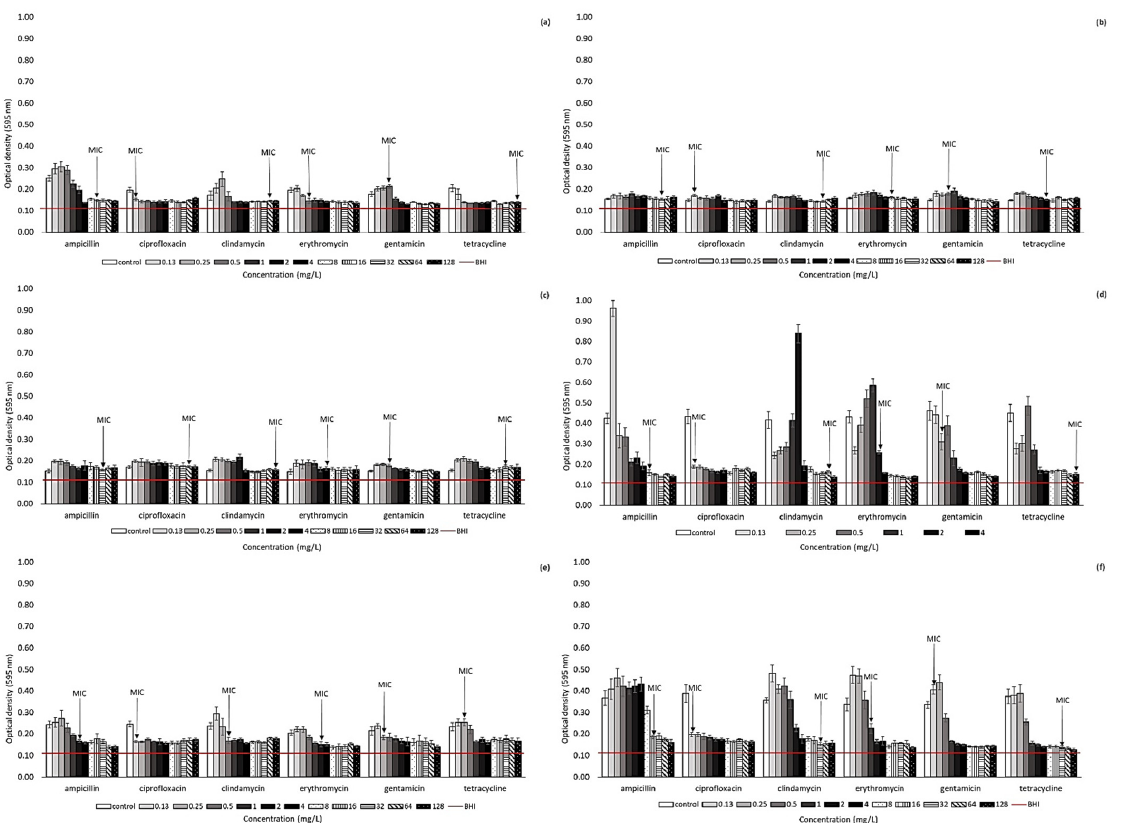
Figure 1. Biofilm formation in the presence of antibiotics. ( a ) Aliarcobacter butzleri CCUG 30484; ( b ) Aliarcobacter butzleri UPa 2013/6 (isolated from food); ( c ) Aliarcobacter butzleri UPa 2013/9 (isolated from wastewater sample); ( d ) Aliarcobacter butzleri UPa 2013/30 (isolated from food); ( e ) Aliarcobacter butzleri UPa 2015/13 (isolated from food); ( f ) Aliarcobacter butzleri UPa 2015/14 (isolated from food). The horizontal line represents the influence of BHI broth (values under horizontal line—biofilm- negative; values above line—biofilm-positive).